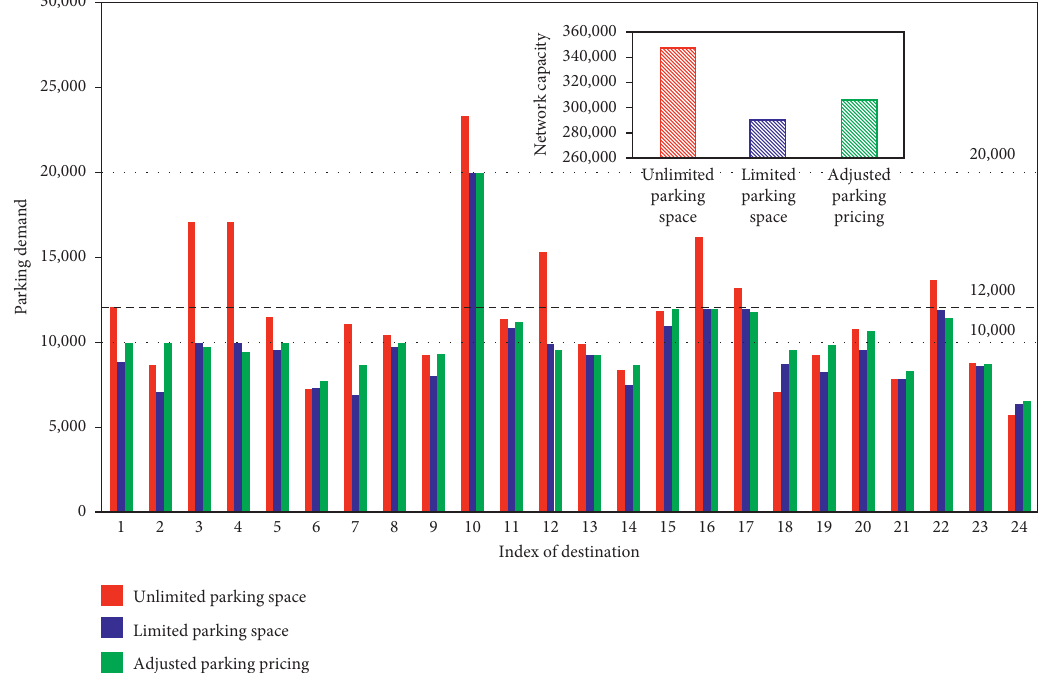
Figure 7: Maximum parking demand under different parking management